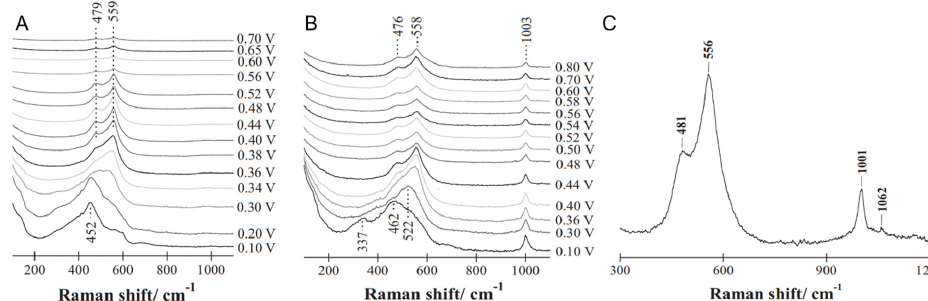
Figure 1. In situ surface-enhanced Raman spectra of Ni(OH) 2 with different potentials and solutions: ( A ) urea-free 5 mol L − 1 KOH, ( B ) 5 mol L − 1 KOH with urea, and ( C ) 5 mol L − 1 KOH with urea [47]. Reproduced with permission [47]. Copyright 2013, Elsevier Ltd.